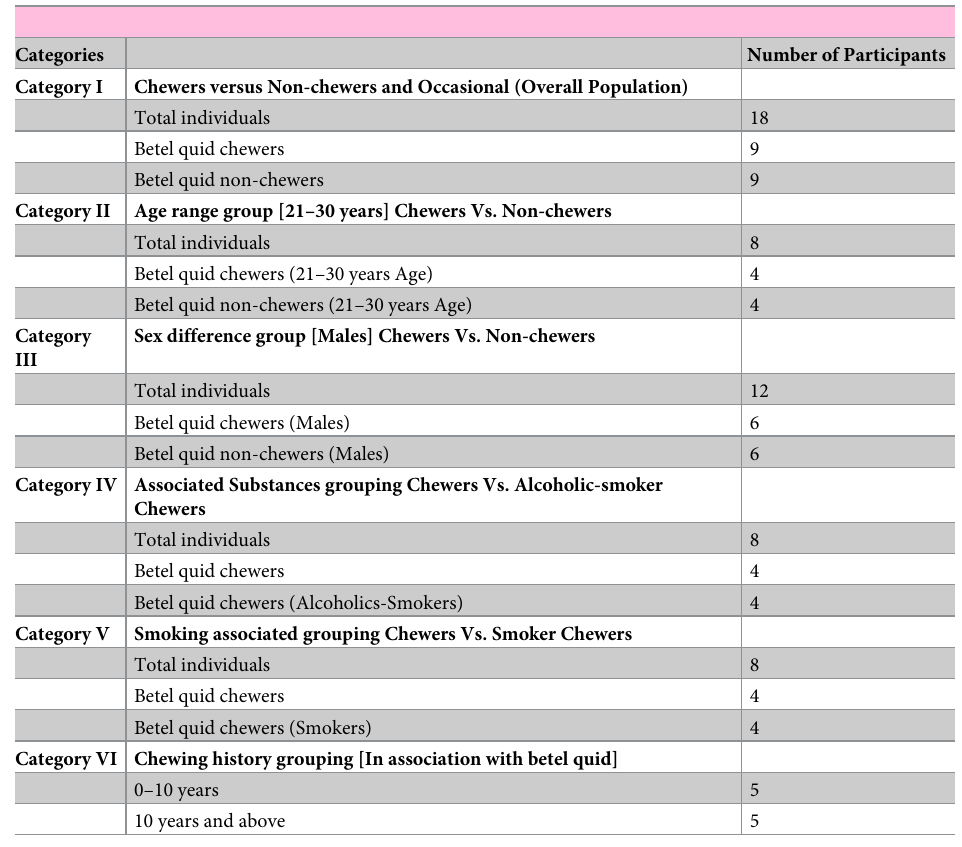
Table 1. Characteristics of study individuals (n =